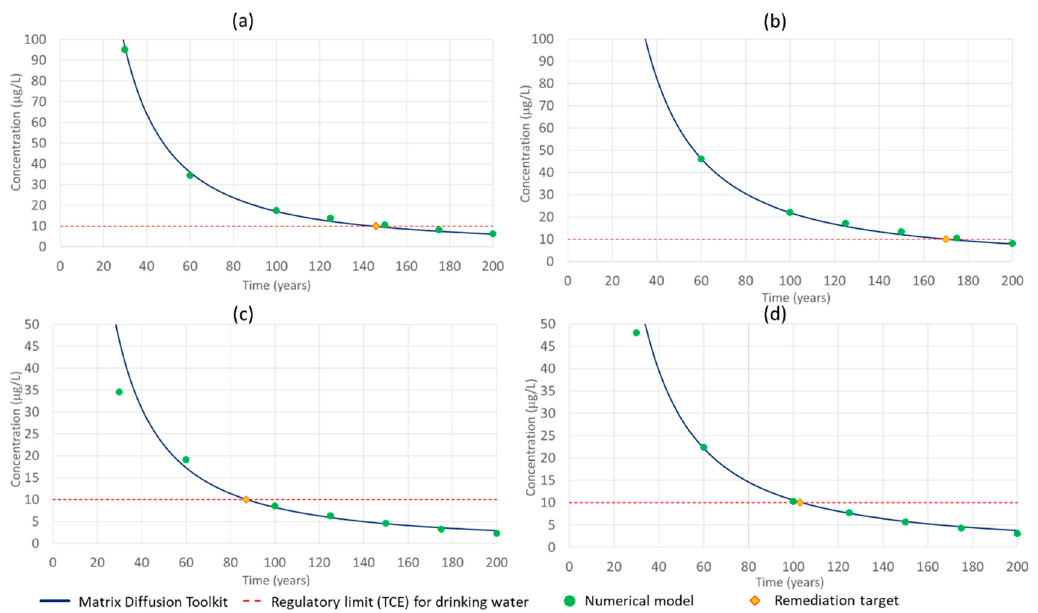
Figure 11. P&T vs. natural attenuation. Concentration distribution over time for SRM and numerical models in OBS1, cases ( a , c ); and in OBS3, cases ( b , d ).